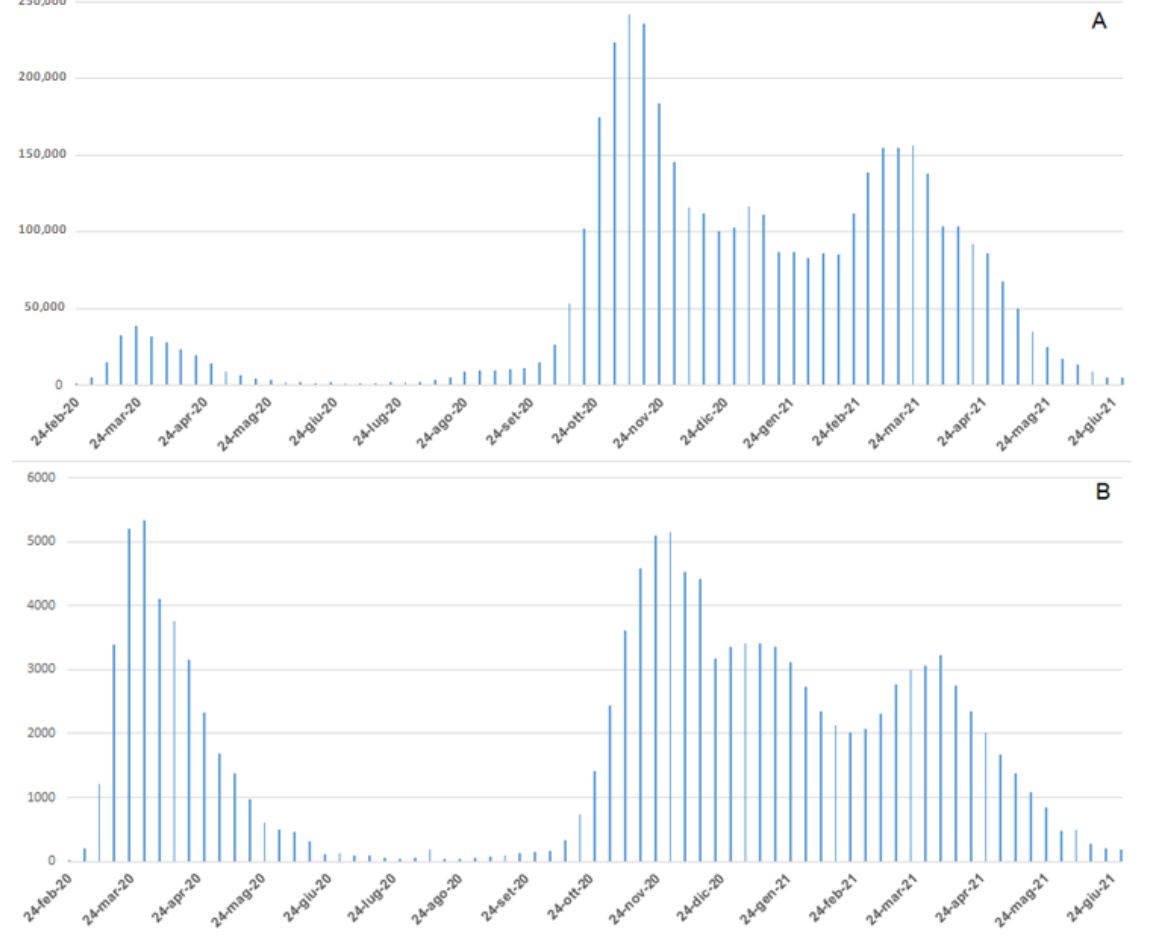
Figure 1. Weekly Italian trends of COVID-19 confirmed cases ( A ) and deaths ( B ).